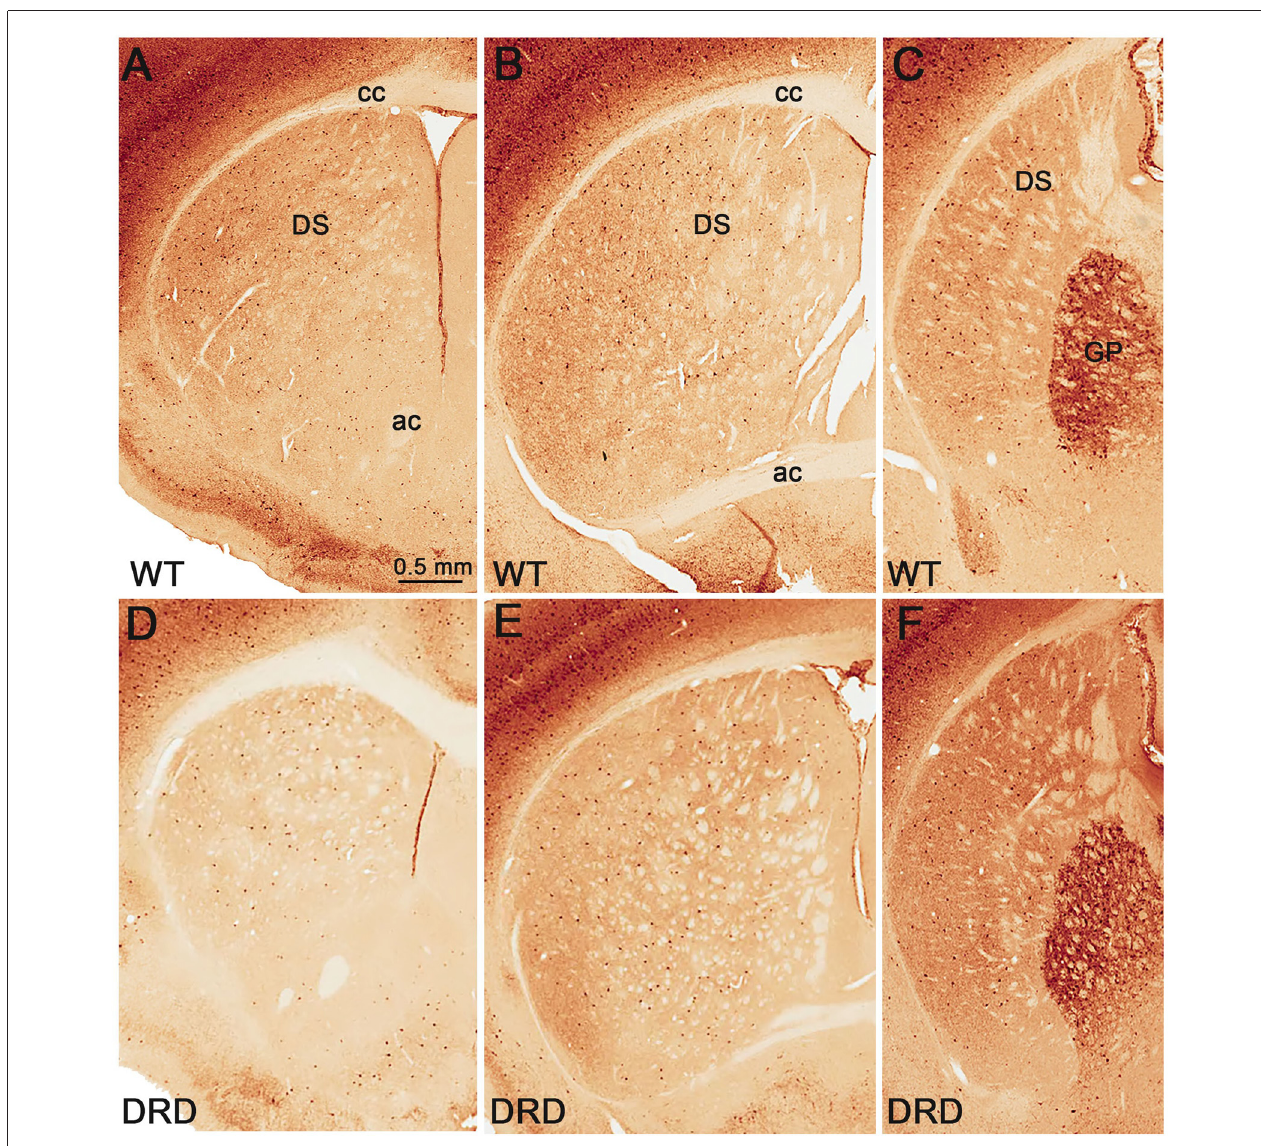
FIGURE 3 | (A–F) Low power views of parvalbumin (PV)-immunostained sections from WT (A–C) and DRD (D–F) mice at the rostral (A,D) , middle (B,E) and post-commissural (C,F) striatal levels. Abbreviations: ac, anterior commissure; cc, corpus callosum; DS, dorsal striatum; GP, globus pallidus. Scale bar in (A) valid for (B–F)